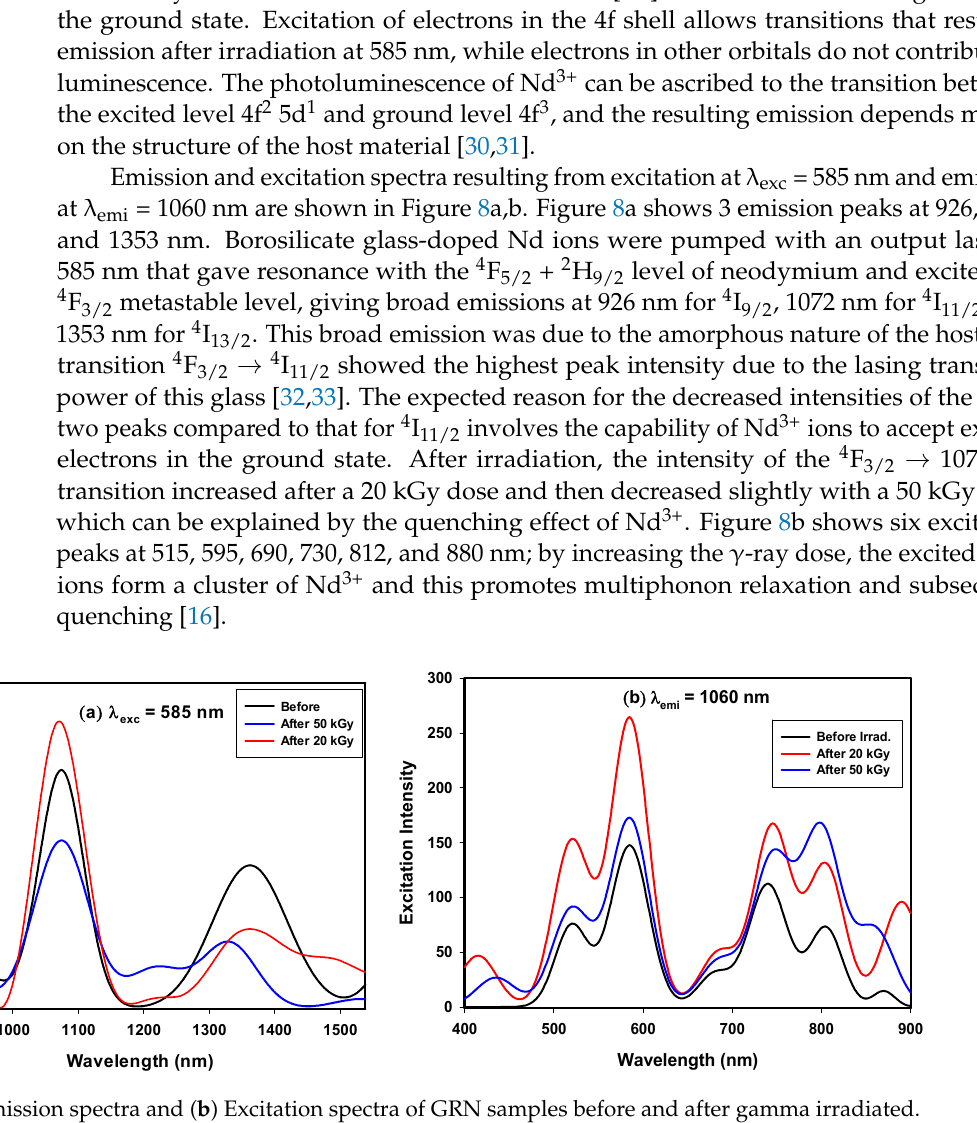
Figure 8. (a) Emission spectra and ( b ) Excitation spectra of GRN samples before and after gamma irradiated.